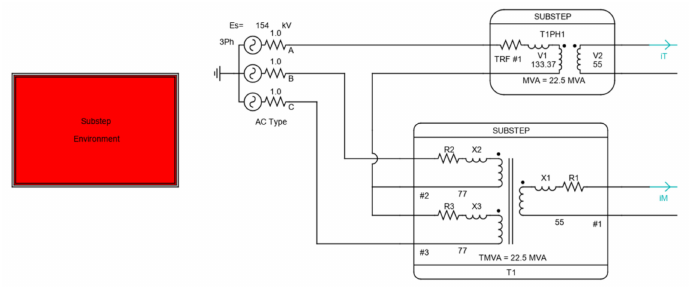
Figure 8. Scott connection using a single-phase transformer and a single-phase three-winding transformer in the Substep